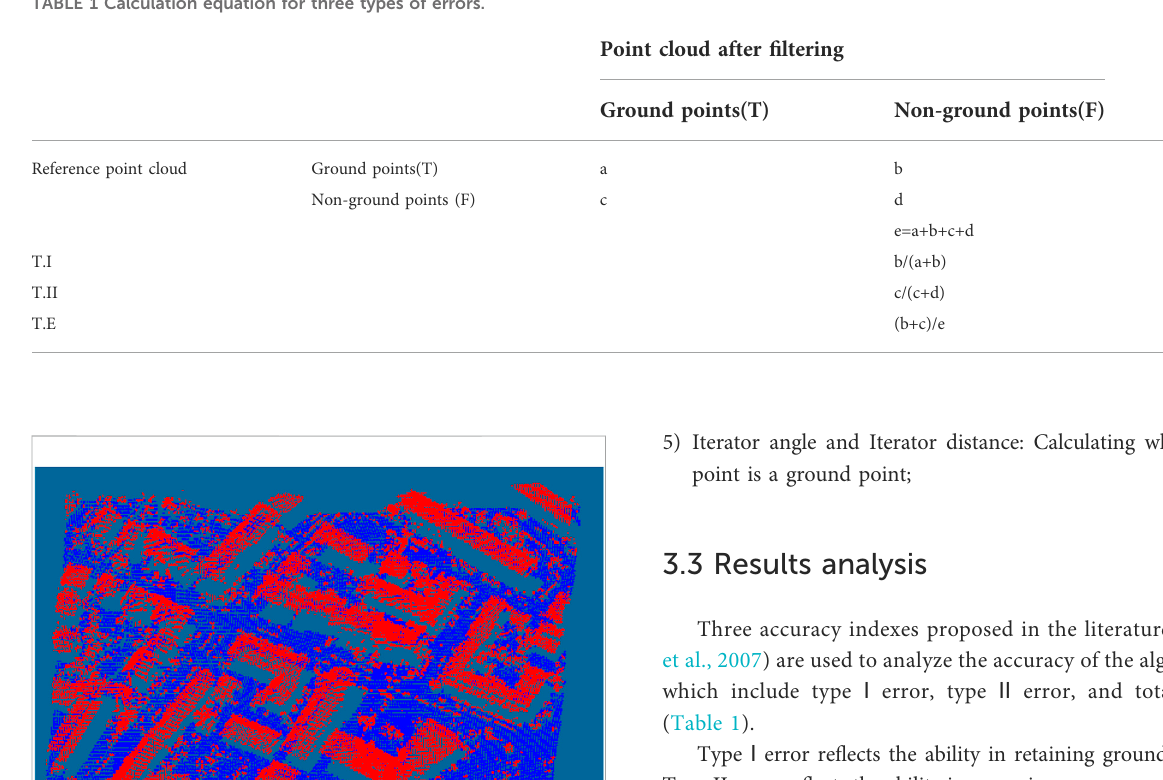
TABLE 1 Calculation equation for three types of errors.